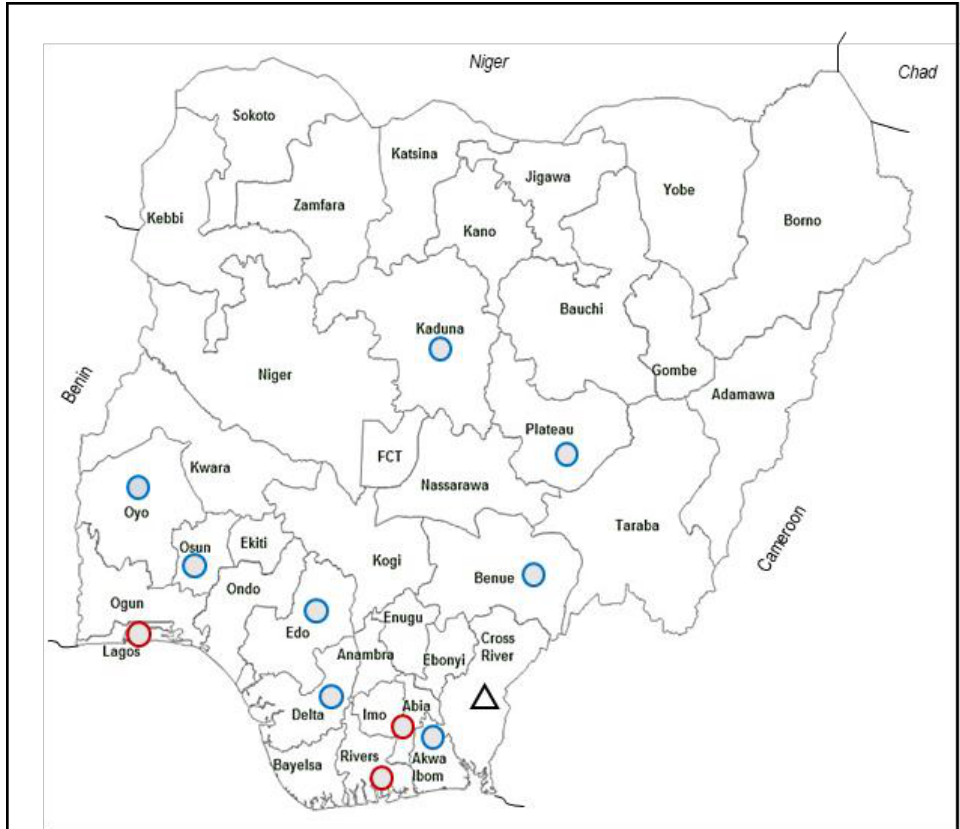
Figure 1. ASF outbreak map. Affected states based on 2020 WAHIS WOAH reports are marked with blue circles. The states in which the samples were tested at the NCFAD are marked with red circles. The Cross River state that reported ASFV genotype I strain is marked with a triangle. This report describes the further characterization of ASFV isolates from the same